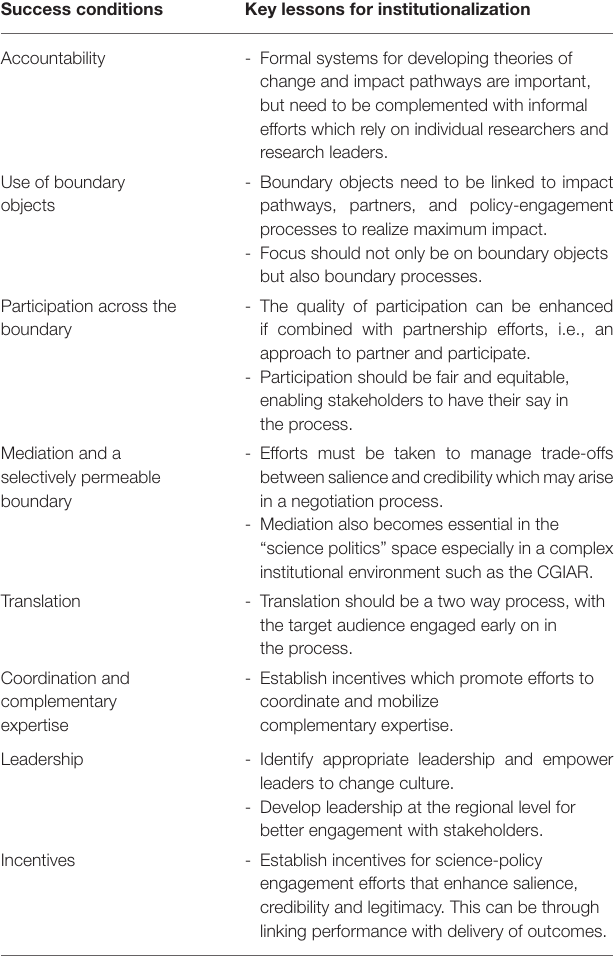
TABLE 3 | Success conditions and lessons for